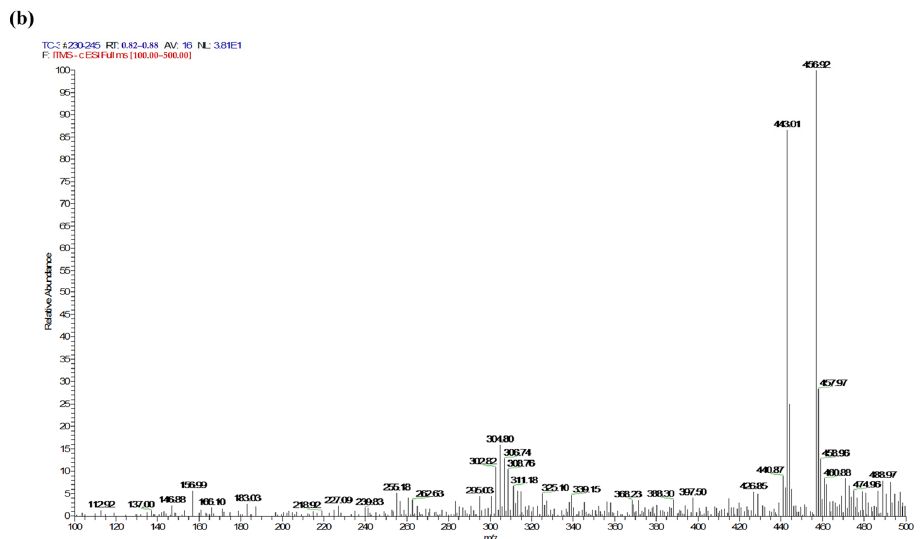
Figure 12. ( a ) HPLC-MS spectra of 0.4Ni/Ti-Bi 2 WO 6 photocatalytic degradation of tetracycline at 0 min; ( b ) HPLC-MS spectra of 0.4Ni/Ti-Bi 2 WO 6 photocatalytic degradation of tetracycline at 140 min.